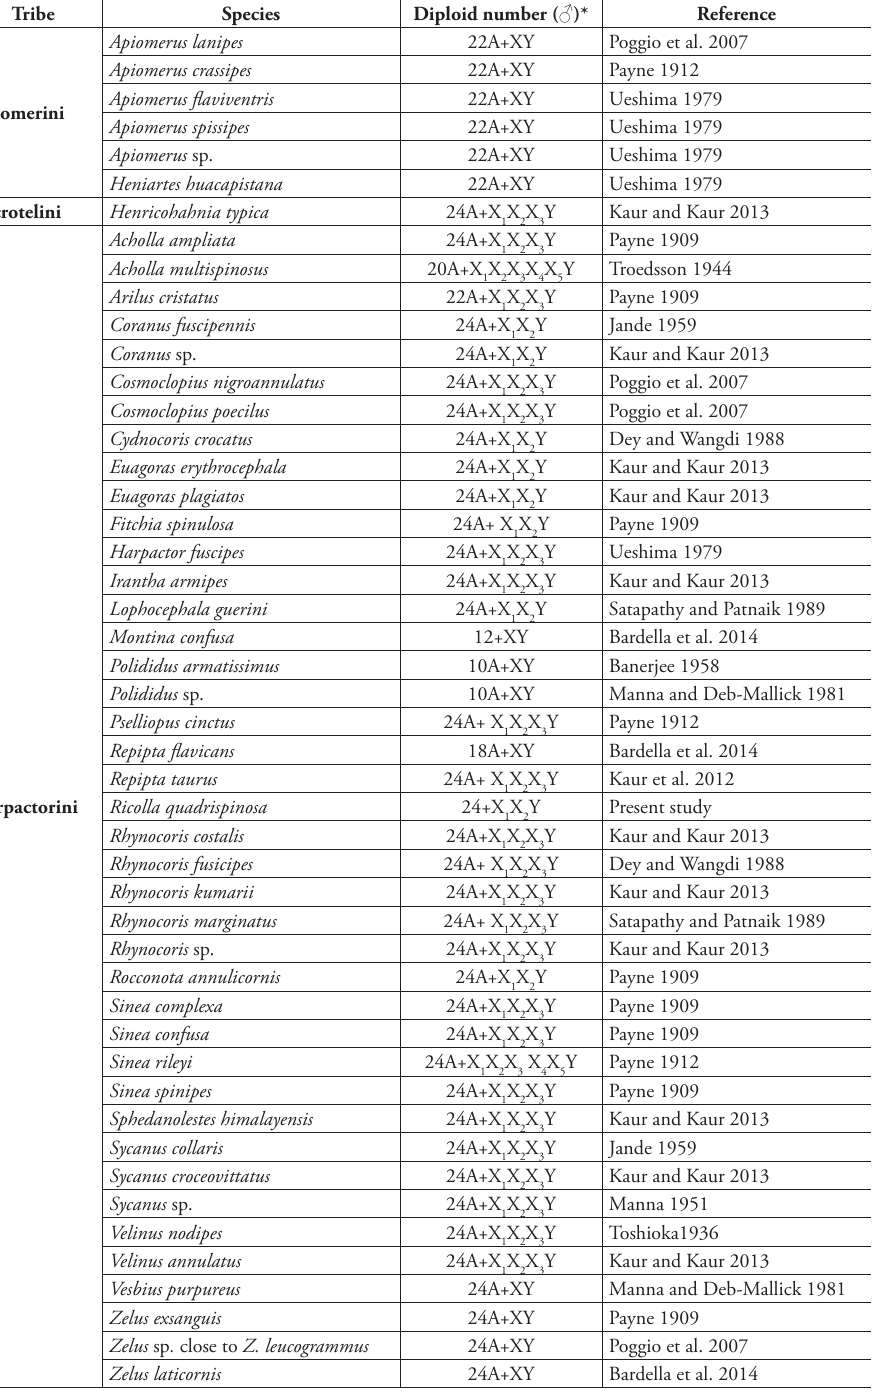
Table 1. Cytogenetic studies in Harpactorinae. Tribe